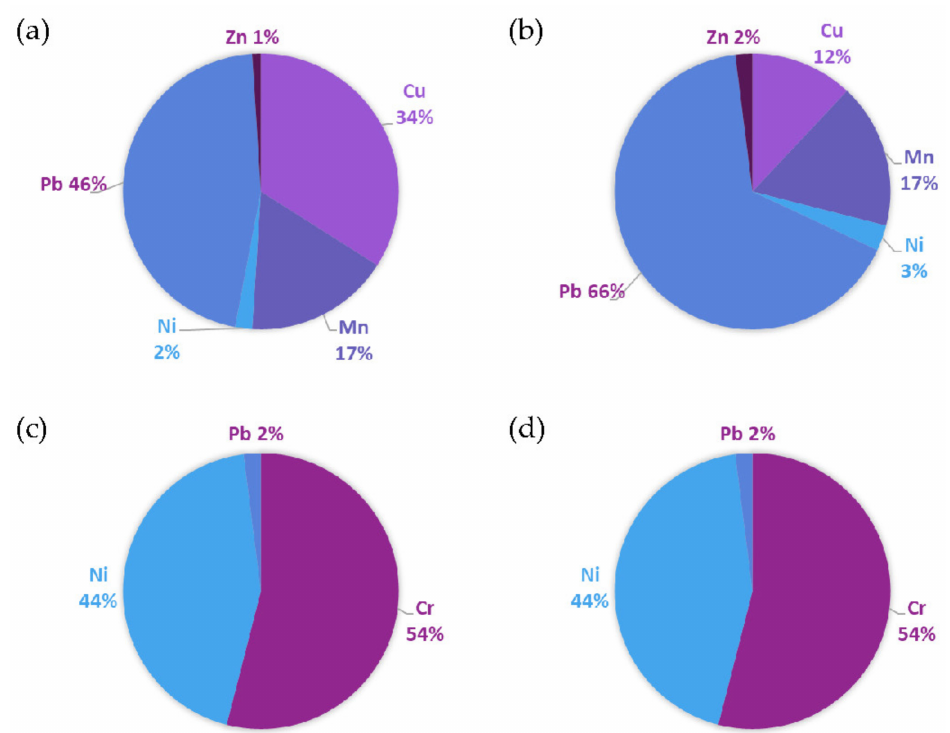
Figure 4. Contribution of PTE to risk: ( a ) non-carcinogenic risks in children, ( b ) non-carcinogenic risks in adults, ( c ) carcinogenic risks in children and ( d ) carcinogenic risks in